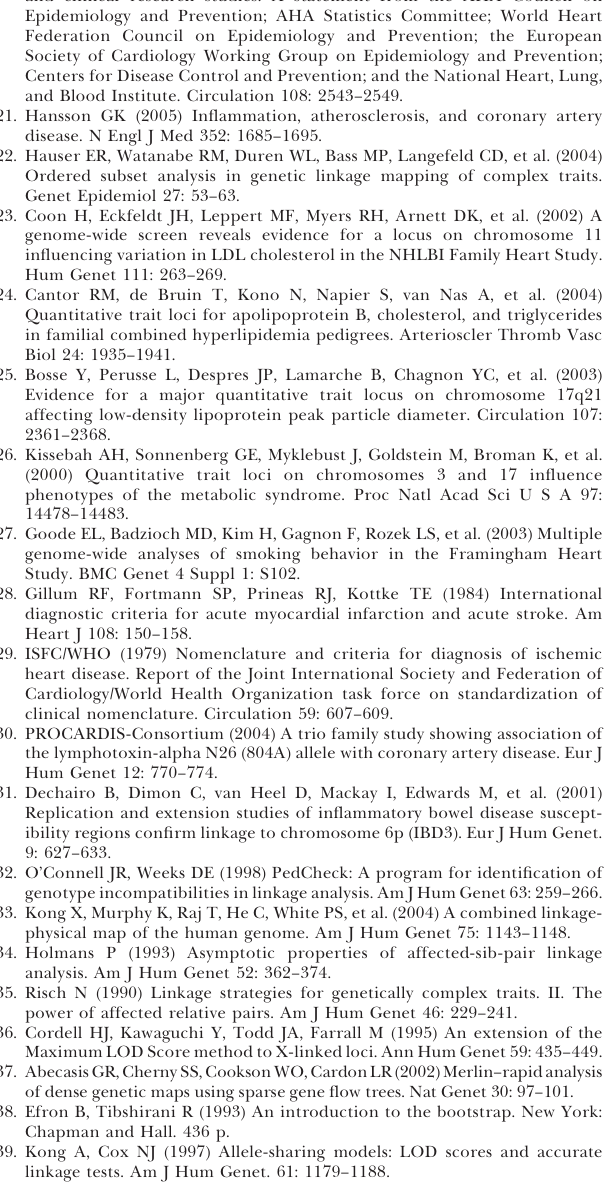
Table S1. 40 Additional Grid-Tightening Markers on Chromosomes 3, 11, and 17 Found at DOI: 10.1371/journal.pgen.0020072.st001 (62 KB